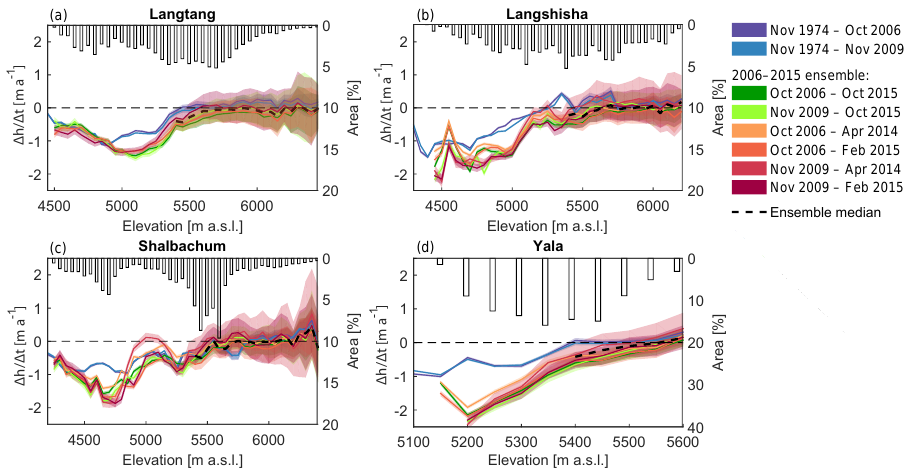
Figure 10. Altitudinal distribution of mean annual elevation change ( (cid:49)h/(cid:49)t ) and altitudinal distribution of glacier area (%) over 50m elevation bands of selected glaciers. Uncertainty bounds correspond to uncertainty as a function of elevation derived for each (cid:49)h/(cid:49)t map individually (Fig. 3). Ensemble median values shown here are used to replace missing data in the accumulation areas of glaciers after outlier exclusion (Sect. 3.2.3). Note that the x axis ranges are different for each